Question: Which visualization type does this figure use?
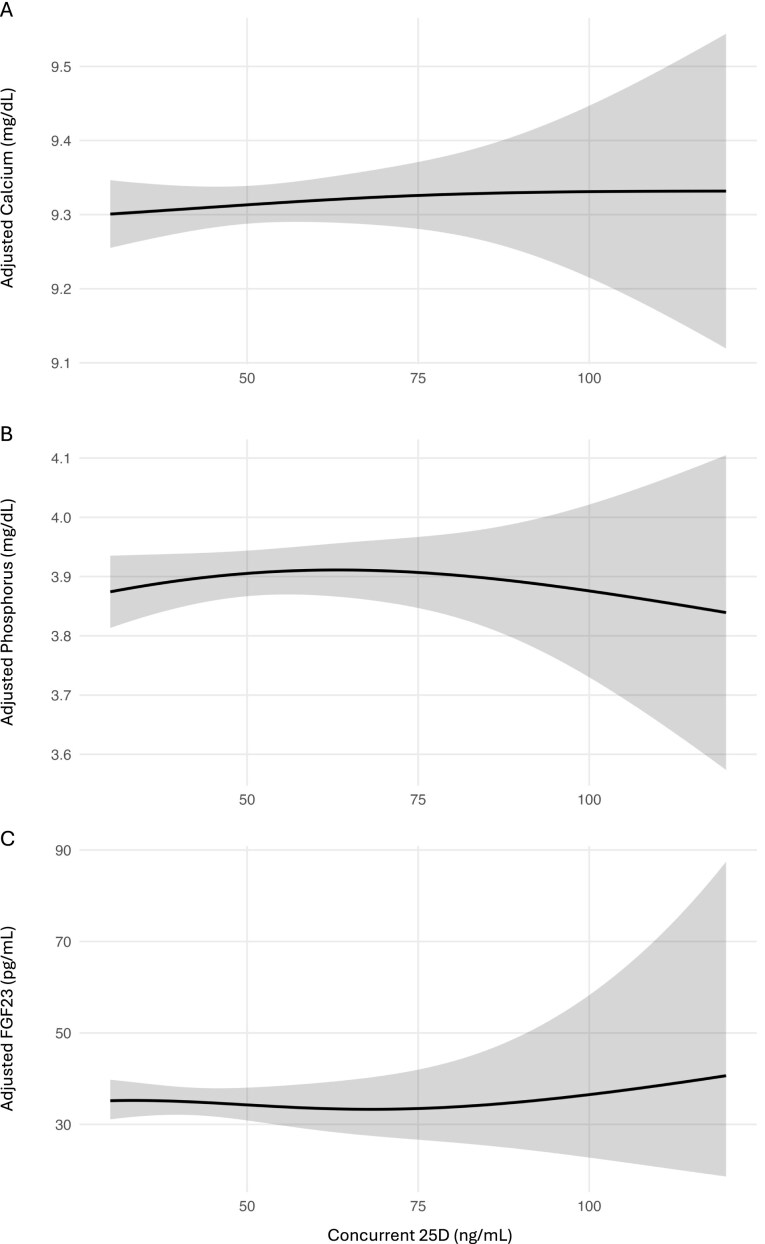
Answer: line